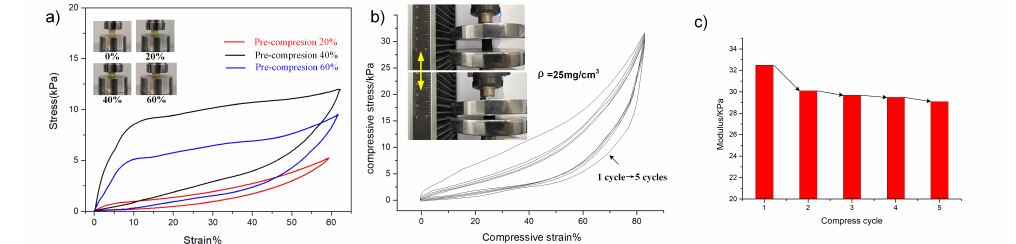
Figure 4. The stress–strain curves of pre-compressive PUS and CNG. ( a ) the stress–strain curves of PUS after preloading at different compressive strain(30%, 50%, 70%) for one cycle; ( b ) the stress–strain curves of the CNG at a strain of 80% for 10 cycles; ( c ) bar graphs of compressive modulus versus CNC content. Inset images are optical images of water droplets on the